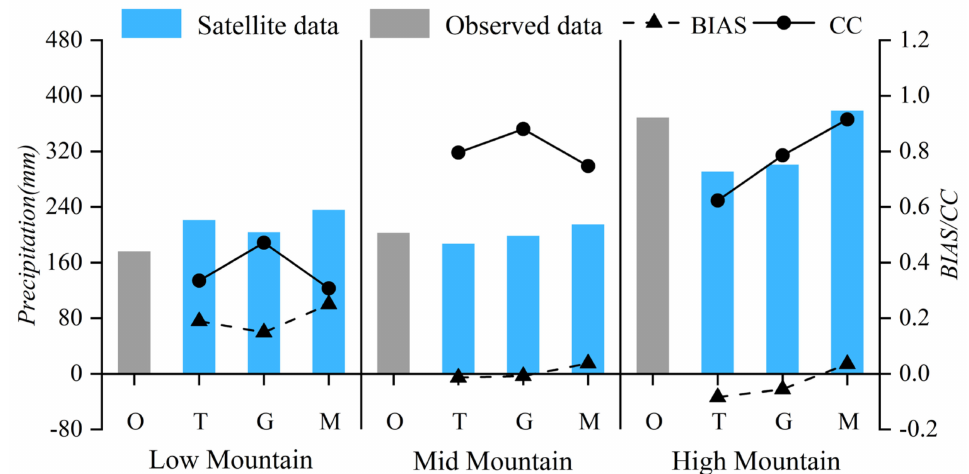
Figure 13. Comparison of average precipitation of three sets of satellite products in different elevation zones. Note: Measured data, TRMM, GPM and MSWEP are in turn from left to right in each elevation